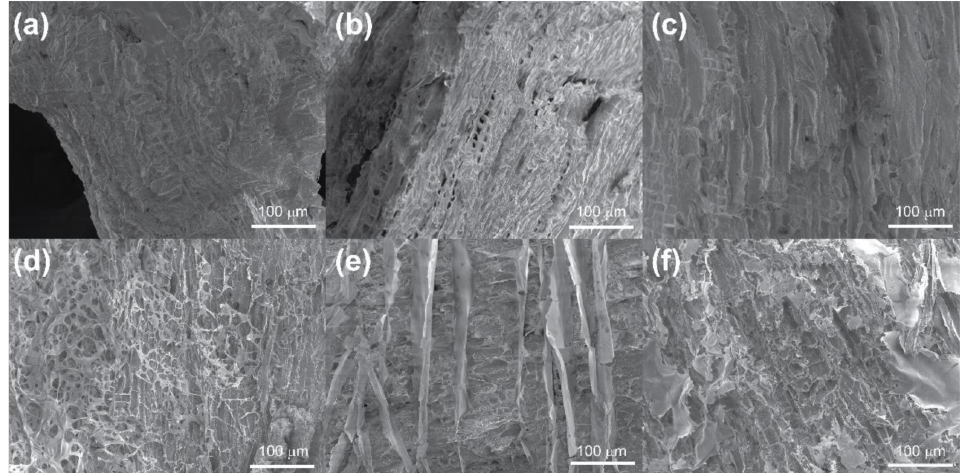
Figure 3. Scanning electron micrographs of archaeological wood with 0.5 wt.% air-dried solutions of ( a ) chitosan, ( b ) alginate, ( c ) CNCs and 0.5 wt.% freeze-dried solutions of ( d ) chitosan, ( e ) alginate and ( f ) CNCs, magnification 554 ×